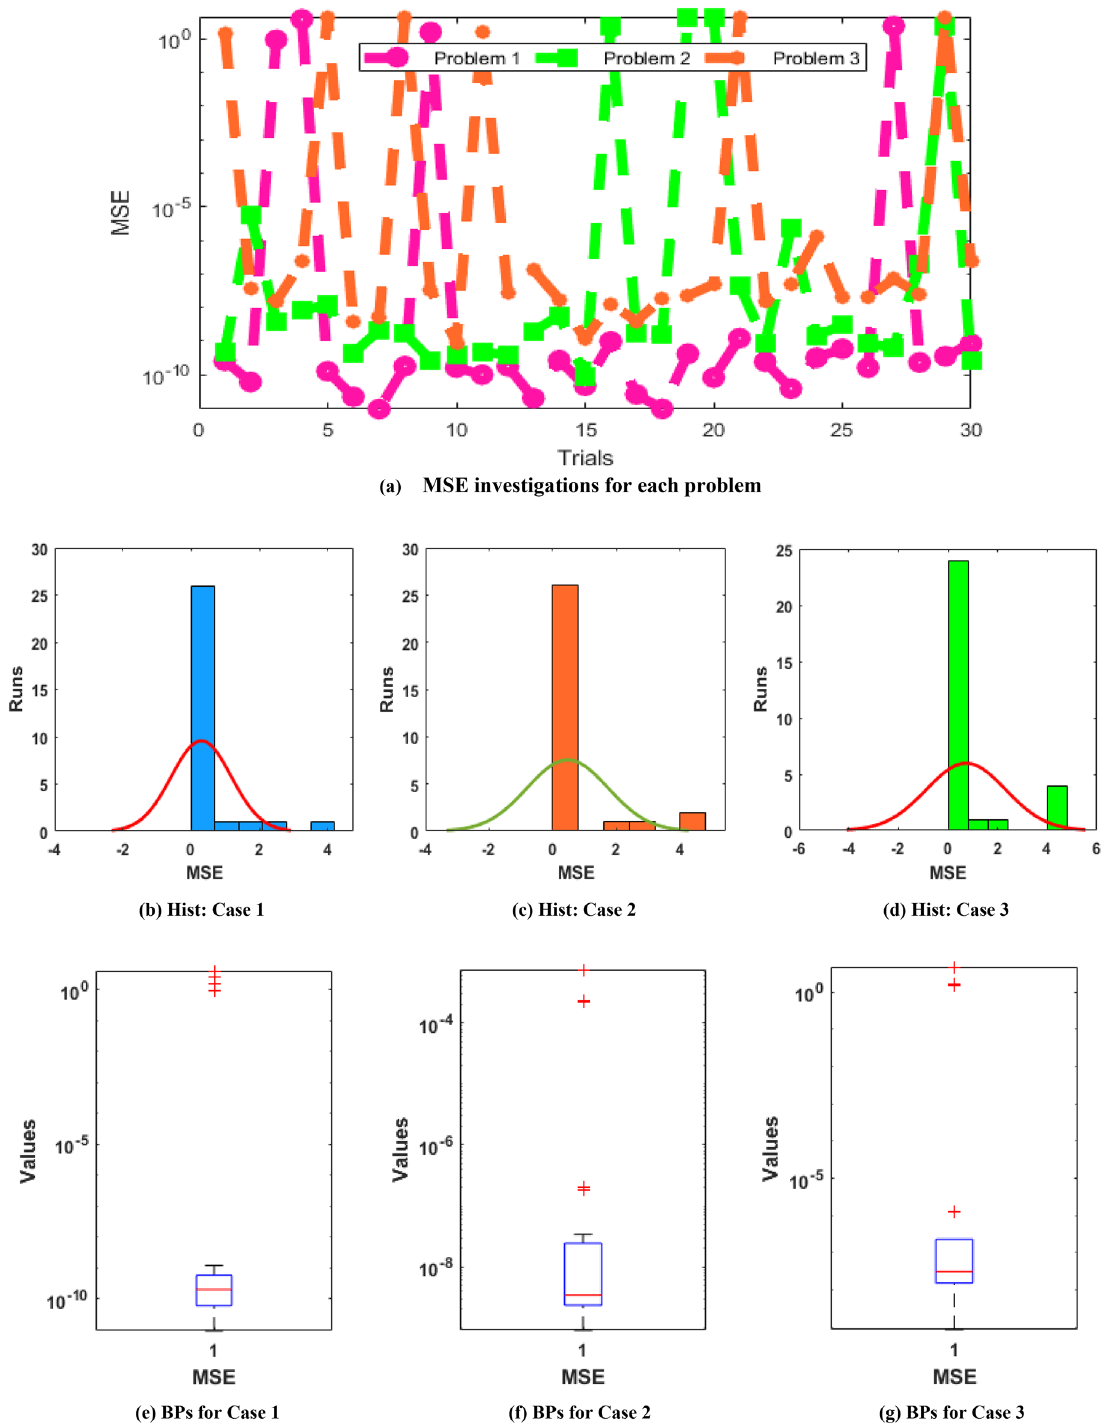
Figure 6. Statistical illustrations via swarming schemes based on the MSE for solving the novel